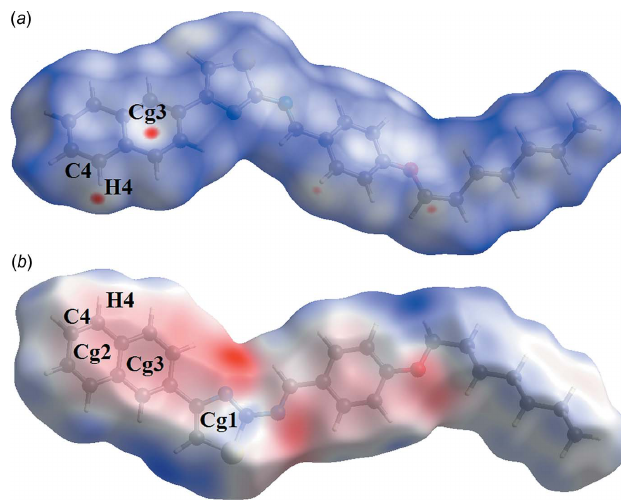
Figure 3 The Hirshfeld surfaces of the title compound mapped over ( a ) d norm , and ( b ) electrostatic